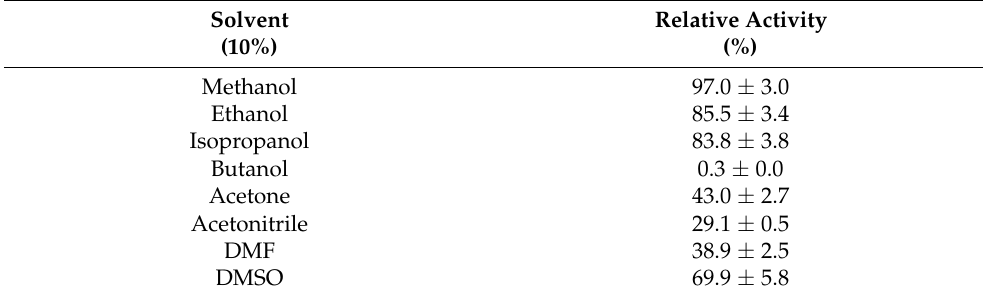
Table 2. Effects of organic solvents on the stability of Est6.